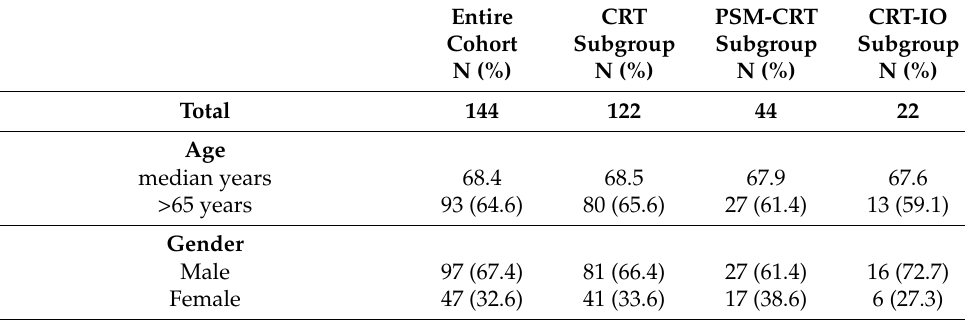
Table 1. Patient and tumor characteristics of entire cohort and chemoradiotherapy (CRT) vs. chemora- diotherapy and durvalumab (CRT-IO) and the Propensity Score Matching (PSM) CRT